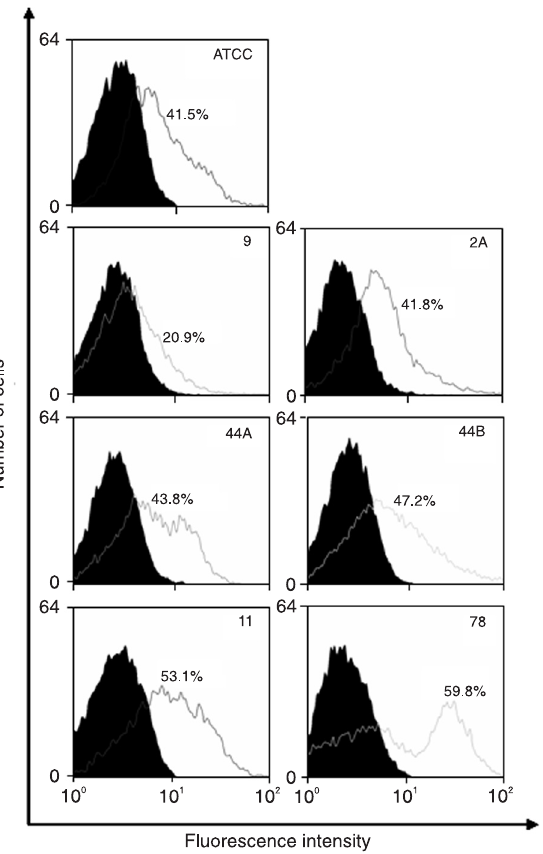
Figure 4. Flow cytometric analysis showing the anti-Sap1-3 anti- body binding to Candida albicans . After growth in YCB-BSA me- dium for 48 h at 37°C under slight agitation, the yeast cells were washed in PBS, fixed in paraformaldehyde and then incubated in the absence (black curves) and in the presence (gray curves) of anti-Sap1-3 antibody at 1:250 dilution for 1 h. Subsequently, the cells were incubated for 1 h with a 1:200 dilution of FITC-labeled goat anti-rabbit IgG and examined in an EPICS ELITE flow cy - tometer. The numbers indicate the percentage of cells in each population that was marked with the anti-Sap